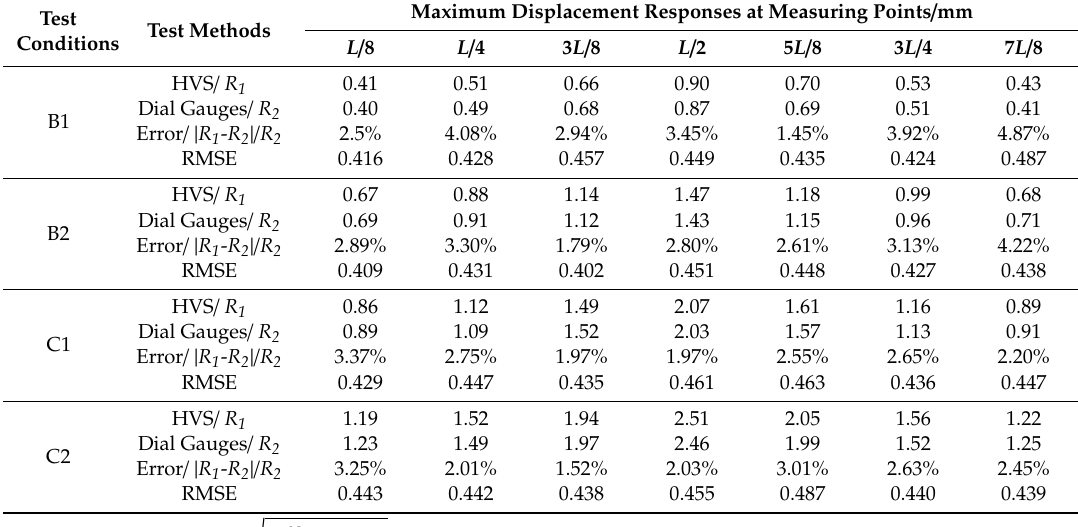
Table 2. Test results comparison of holographic visual sensor (HVS) and dial gauges.